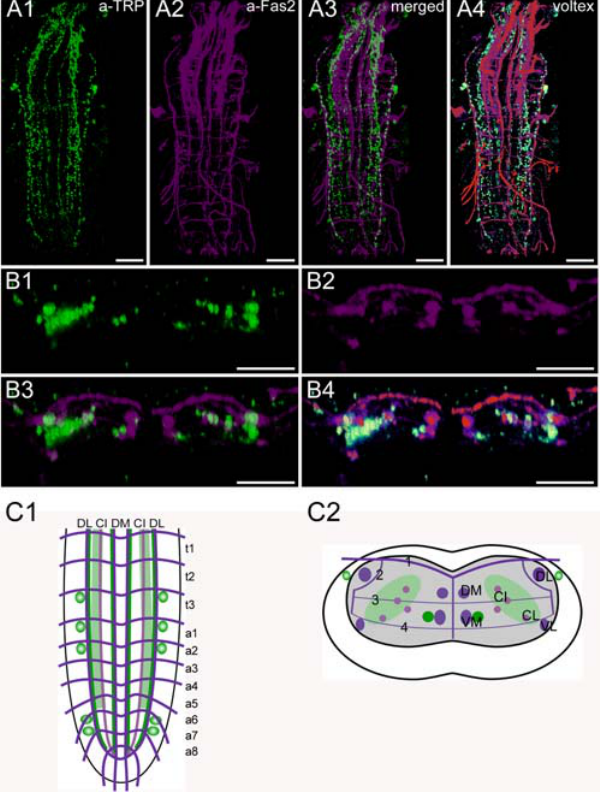
Figure 12. Morphology of tachykinin-related peptide-expressing neurons. Mapping of TRP-IR neurons in whole-mount preparations of the thoracic and abdominal neuromeres of L3 larva in the FasII landmark system. A) Dorsal view. B) Transversal view at the height of neuromere a1. C) Idealized dorsal scheme. D) Idealized transverse scheme. Scale bars: 50 m m in A ), 25 m m in B . Immunostaining is shown in green, Fas2 in magenta.